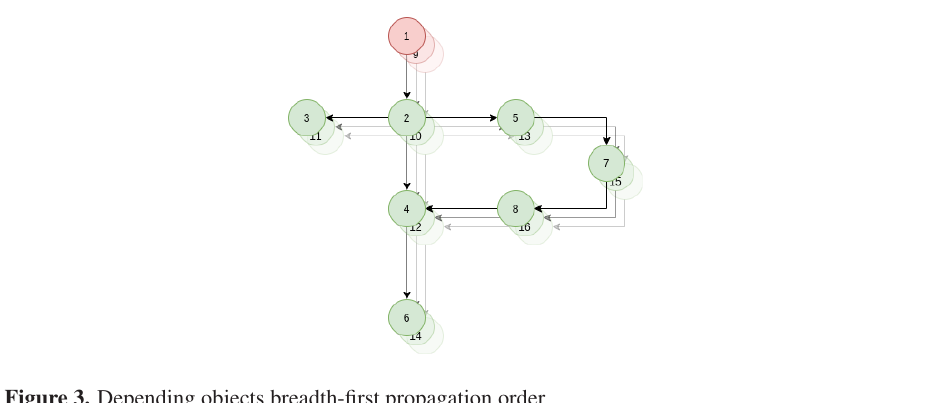
Figure 3. Depending objects breadth-first propagation